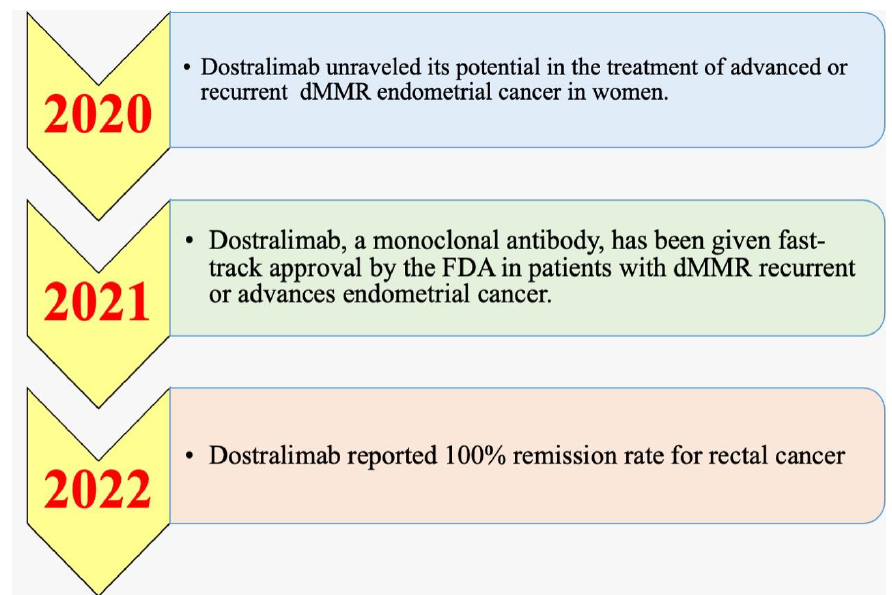
Figure 3. Timeline for the medicine dostarlimab, from when it first showed potential in treating certain women with EC until it was reported to have a complete remission rate for rectal cancer.